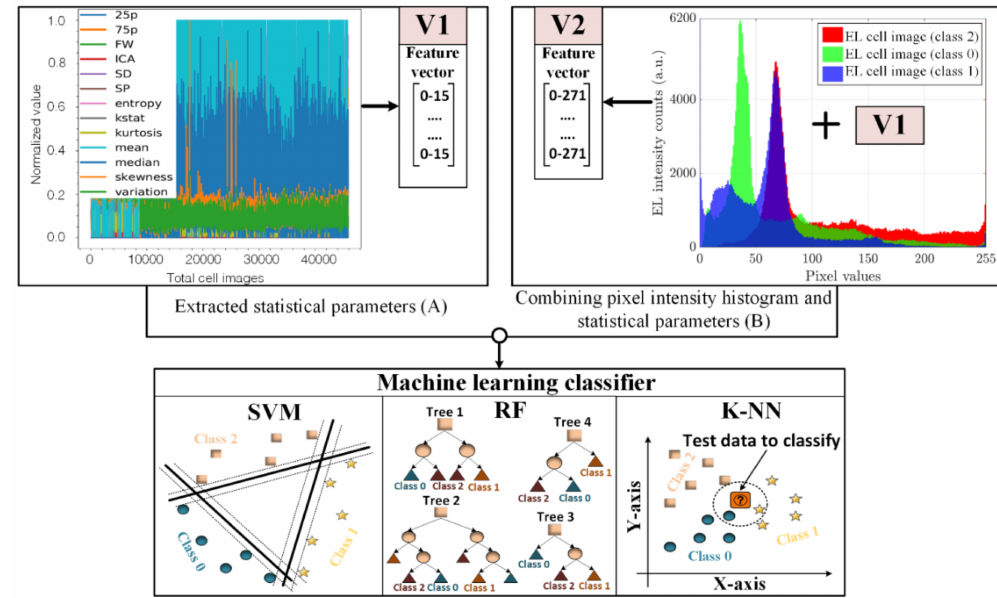
Figure 4. ( A ) Extracted statistical parameters (V1; 16 features); ( B ) combined pixel intensity histogram and statistical parameters (V2; 271 features) used as inputs for three ML classifiers.